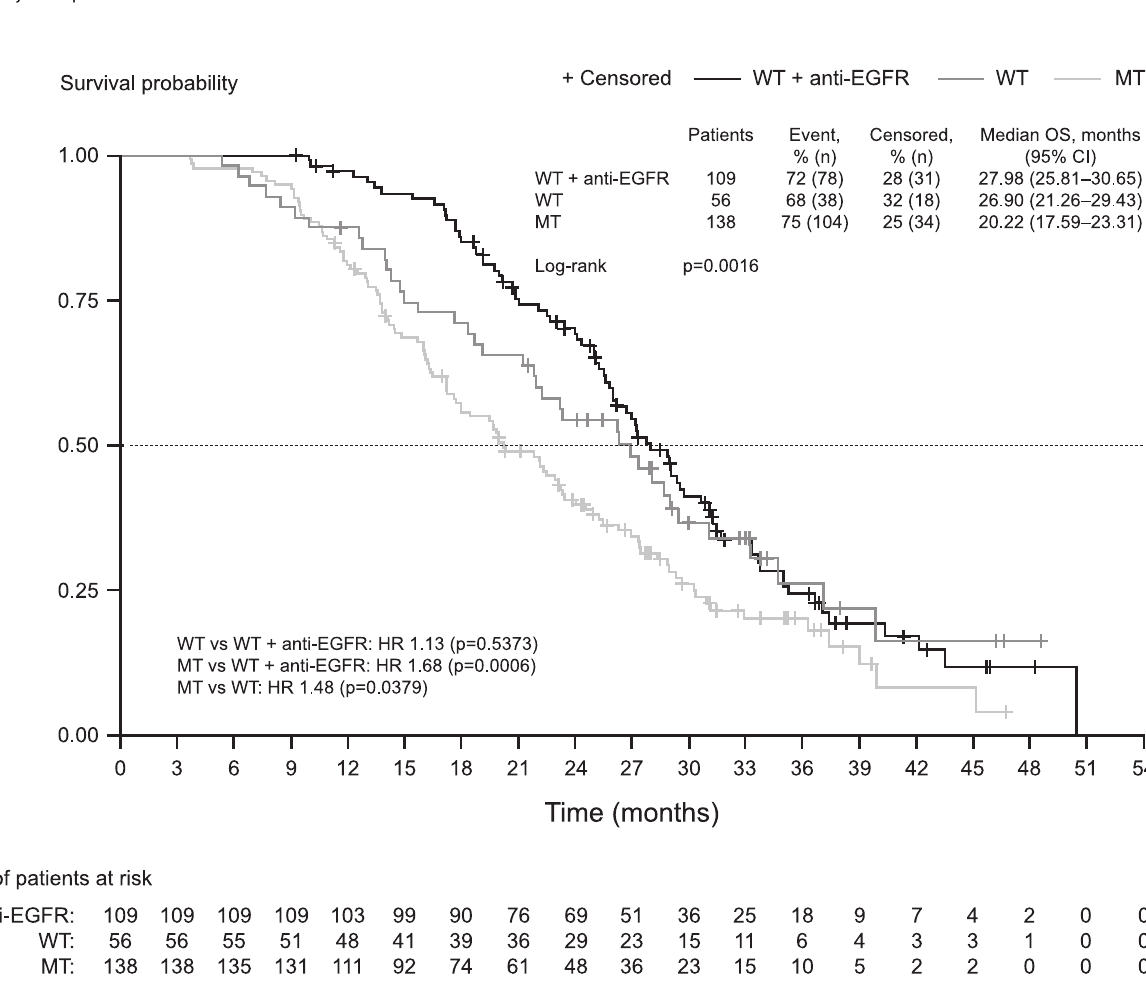
Figure 3. Effect of post-progression anti-EGFR therapy on survival. Abbreviations: EGFR, epidermal growth factor receptor; HR, hazard ratio; MT, mutant; WT, wild type.